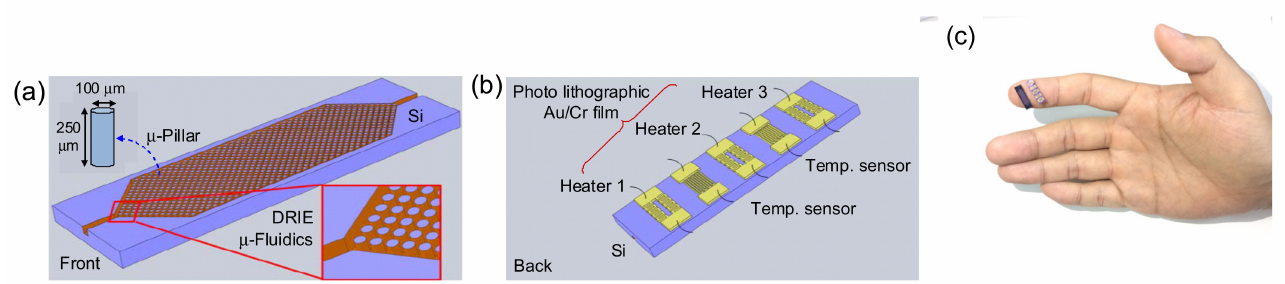
Figure 1. ( a ) Front side, ( b ) back side, and ( c ) photo of the µ -preconcentrator